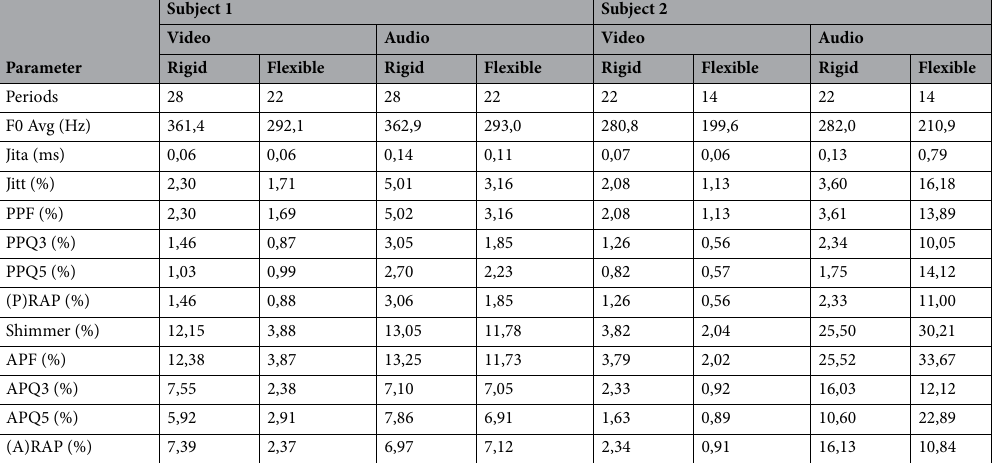
Table 1. Parameters obtained from rigid and flexible optics during video and audio HSV examination. Measures are derived from glottovibrograms, two-dimensional spatiotemporal representations of changes of the glottal area during phonation, extracted from HSV recordings. Similar quantitative analysis was performed for acoustic signal, recorded during video examination with a microphone attached to endoscope. F0 Avg— average fundamental frequency; PPF—Period Perturbation Factor; PPQ3—Period Perturbation Quotient; PPQ5—Period Perturbation Quotient; (P)RAP—Period Relative Average Perturbation; APF—Amplitude Perturbation Factor; APQ3—Amplitude Perturbation Quotient; APQ5—Amplitude Perturbation Quotient; (A)RAP—Amplitude Relative Average Perturbation; where 3 or 5(k) is the odd number of width of the local averaging